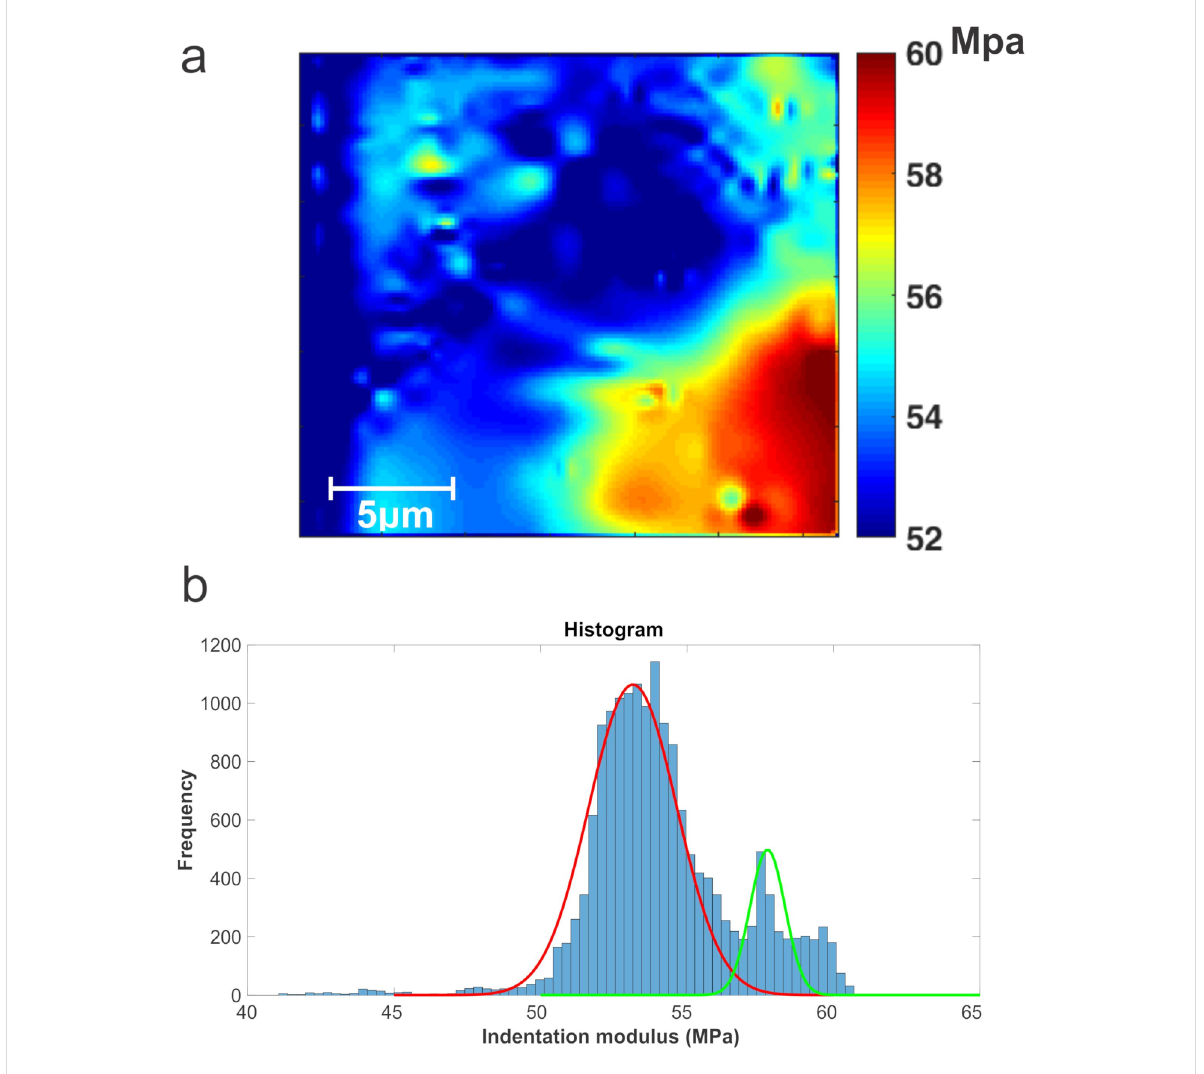
Figure 7: Results for a graphite film on a glass substrate: a) indentation modulus mapping and b) histogram for the mapping.